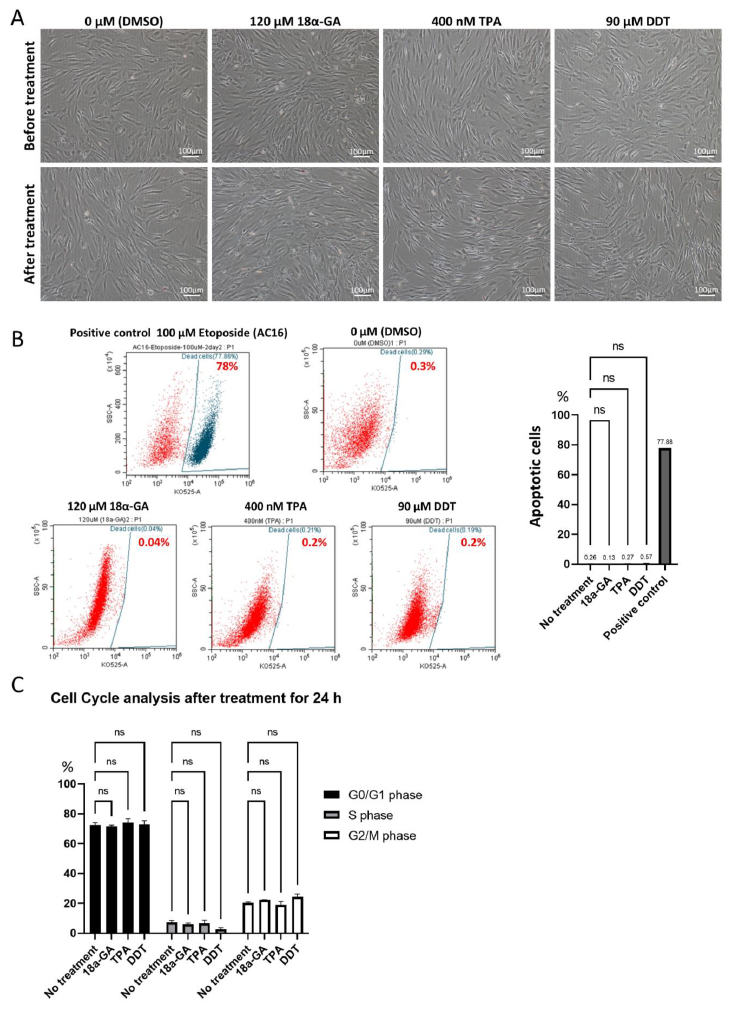
Figure 2. Effect of 18 α -GA-, TPA- and DDT-treatments on Muse cells. ( A ) Phase contrast microscopic images of Muse cells before and 24 h after treatment either with 0.1% DMSO (control), 120 µ